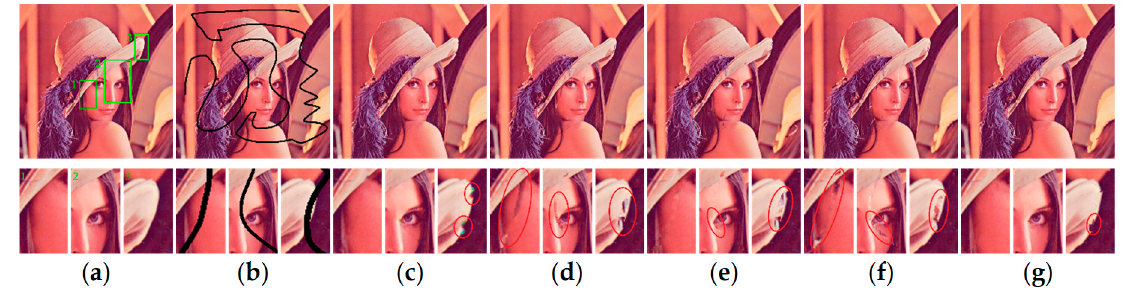
Figure 7. Comparison of inpainting results for Lena (512 × 512) ( a ) Ground truth; ( b ) incomplete image; ( c ) CDD model [4]; ( d ) Criminisi’s method [10]; ( e ) Liu’s method [17]; ( f ) Zhou’s method [18]; ( g ) proposed method.